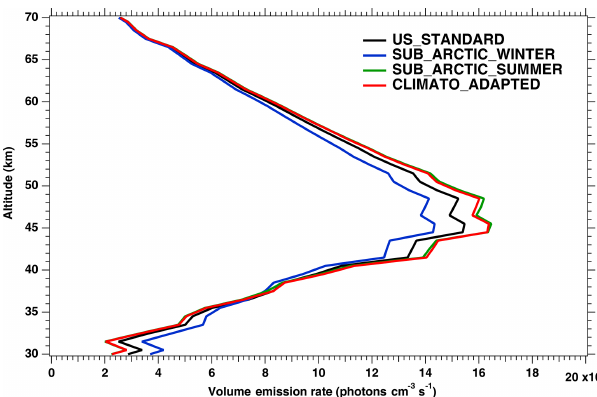
Figure B2. VER airglow profiles obtained by taking into account O 2 absorption using a climatological atmospheric profile: SUB- ARCTIC_SUMMER (green curve), SUBARCTIC_WINTER (blue curve), US STANDARD (black curve), and CLIMATO_ADAPTED (red curve). In the case of this profile measured in January at latitude of − 39.9 ◦ , the adapted climatology corresponds to the MIDLAT- SUMMER